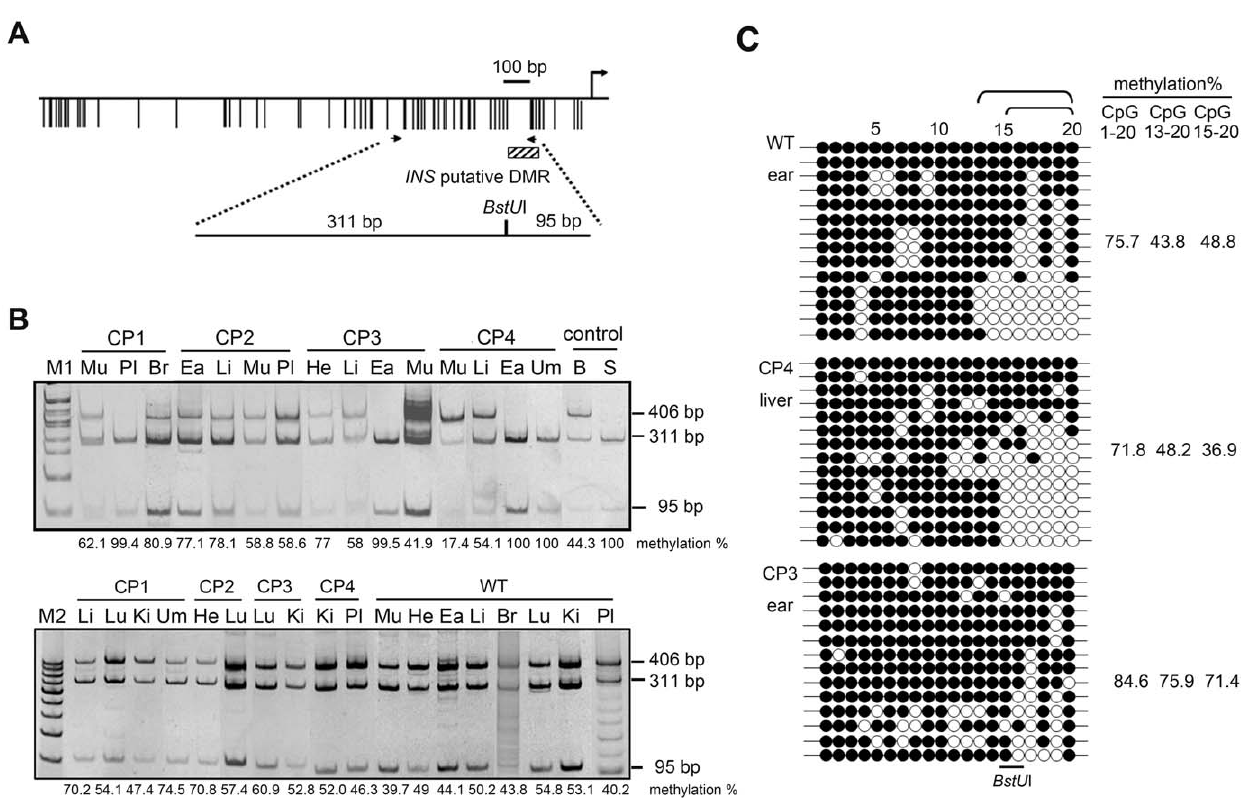
Figure 4. Dissection of the methylation status of the putative INS DMR in cloned and wild-type pigs. (A) A schematic diagram of the pig INS gene showing the relative positions of promoter, exon 1 and CpG islands. The black arrow indicates the location of the primer set. The striped box indicates the putative DMR. The horizontal line indicates the CpG site. The PCR product was digested with Bst UI. (B) The putative DMR of the maternally imprinted INS gene in cloned pigs and wild-type pigs was analyzed by COBRA. The numbers under the figure in the WT panel indicate the average methylation percentage of three wild-type pigs. (C) Bisulfite sequencing of the INS putative DMR in WT ear, CP4 liver, and CP3 ear. Open and closed circles indicate unmethylated and methylated CpG sites, respectively. The top number indicates the CpG site position of the analyzed INS putative DMR. The bottom line indicates the Bst UI recognition site. Fourteen clones of each tissue were sequenced. The methylation percentage calculations were divided into three parts: CpG sites 1 to 20 (all), CpG sites 15 to 20, and CpG sites 13 to 20. For example, WT ear showed a total methylation percentage of 75.7 (212 methylated CpG sites/20 CpG sites 6 14 clones=75.7%). M1: Bio 100 DNA ladder; M2: 500 bp DNA ladder; Br: brain; Ea: ear; He: heart; Ki: kidney; Li: liver; Lu: lung; Mu: muscle; Pl: placenta; Um: umbilical cord; B: blood; S: blood treated with Sss I; W: ddH 2 O.